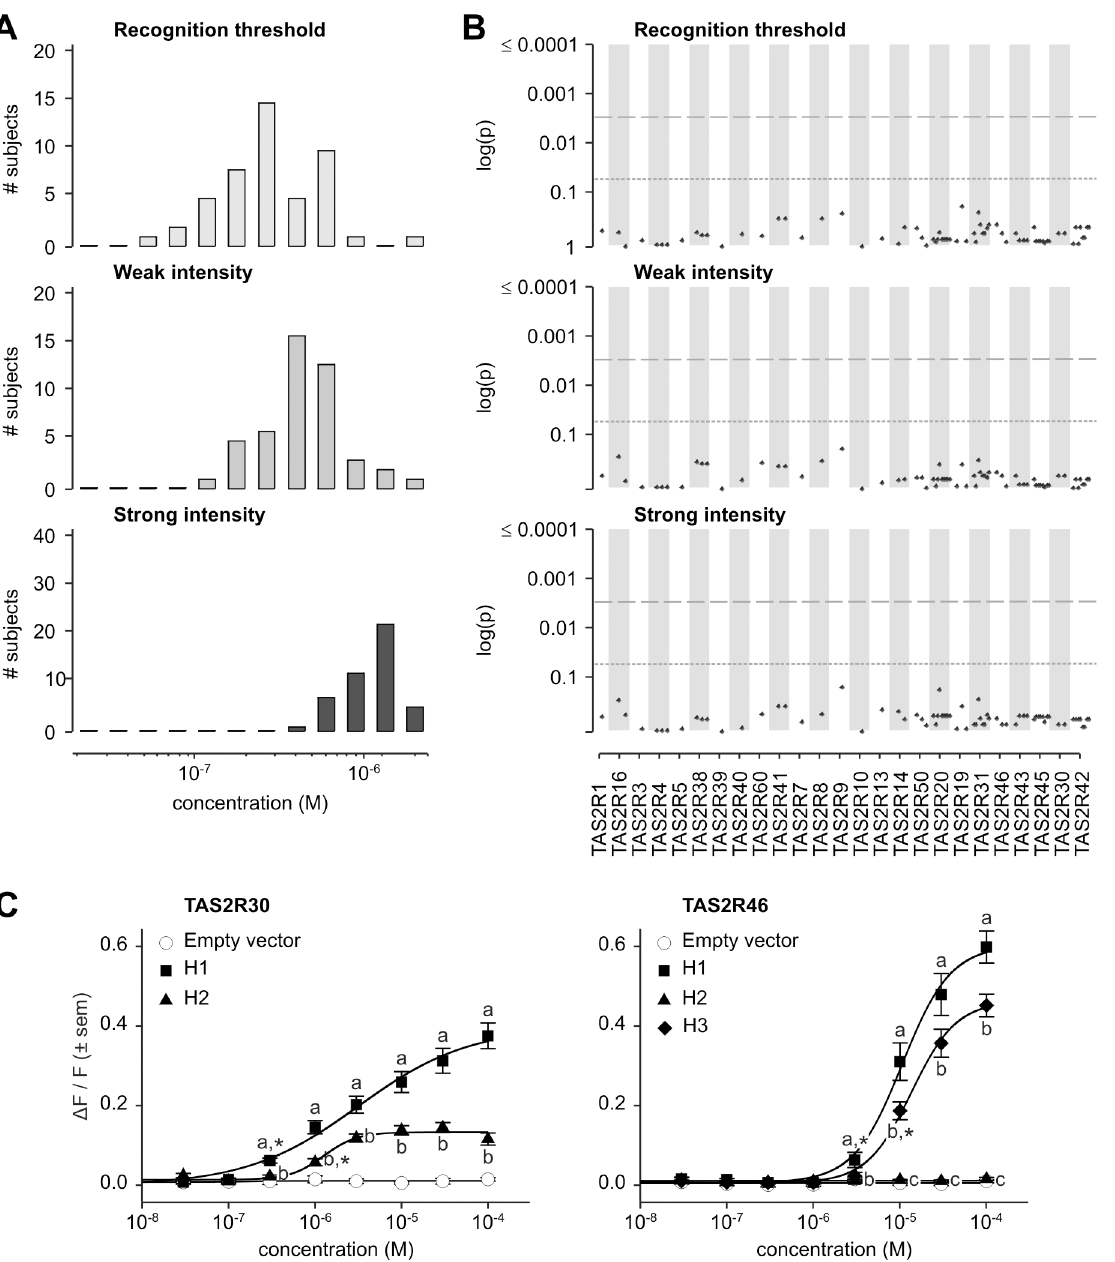
Fig 8. Absinthin phenotypes, genotype-phenotype associations, and functional assays. (A) Distribution of bitter taste recognition thresholds, and concentrations perceived as weak and strong. (B) Genotype-phenotype associations for common SNPs (frequency > 0.05). Dashed line indicates significance threshold following corrections for multiple testing. Solid line indicates uncorrected significance threshold. (C) Allele-specific dose response curves for loci harboring SNPs showing significant phenotypic associations.